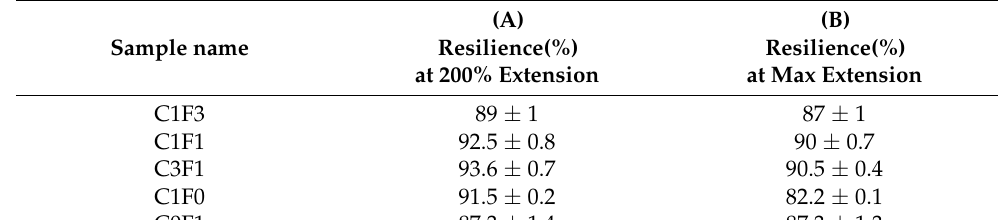
Table 2. Calculated resilience values of fabricated hydrogels at 200% extension (A) and at maximum extension achieved by each composition individually (B).